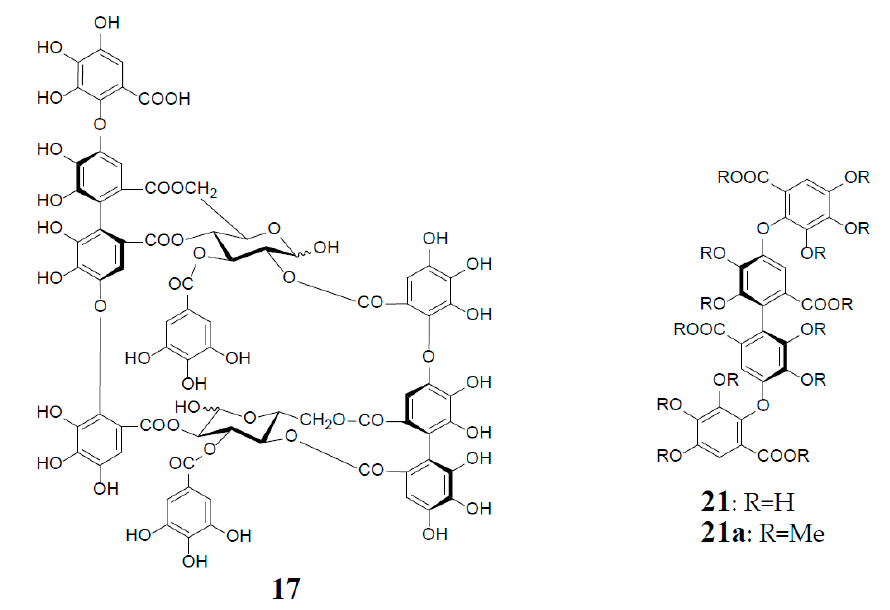
Figure 4. Structures of oenothein A ( 13 ), woodfordins D ( 14 ), E ( 15 ), and F ( 16 ), pentamer ( 18 ), hexamer ( 19 ), and heptamer ( 20 ), Structures of woodfordin I ( 17 ) and woodfordinic acid ( 21 ). Woodfordinic acid ( 21 ), which is the parent acid participating in the linkage of three glucose cores (I–III) in oenothein A ( 13 ) and woodfordin D ( 14 ), was characterized as a gallic acid tetramer by spectral analyses (NMR, MS, and CD) of its methylated derivative ( 21a ; C 42 H 46 O 20 ) obtained upon permethylation of 14 followed by methanolysis [21]. Its symmetrical structure was evidenced by 2 aromatic proton singlets and 7 methoxy proton signals, and 21 carbon signals comprising of 12 sp 2 , 2 ester carbonyl and 7 sp 3 carbon signals in the 1 H- and 13 C-NMR spectra, respectively (Figure 4). Woodfordin I ( 17 ), a dimer possessing the woodfordinoyl group, is likely a catabolic metabolite of 13 and 14 . Interestingly, woodfordin I was also isolated from a traditional Chinese medicine, Chamaenerion (= Epilobium ) angustifolium [24].